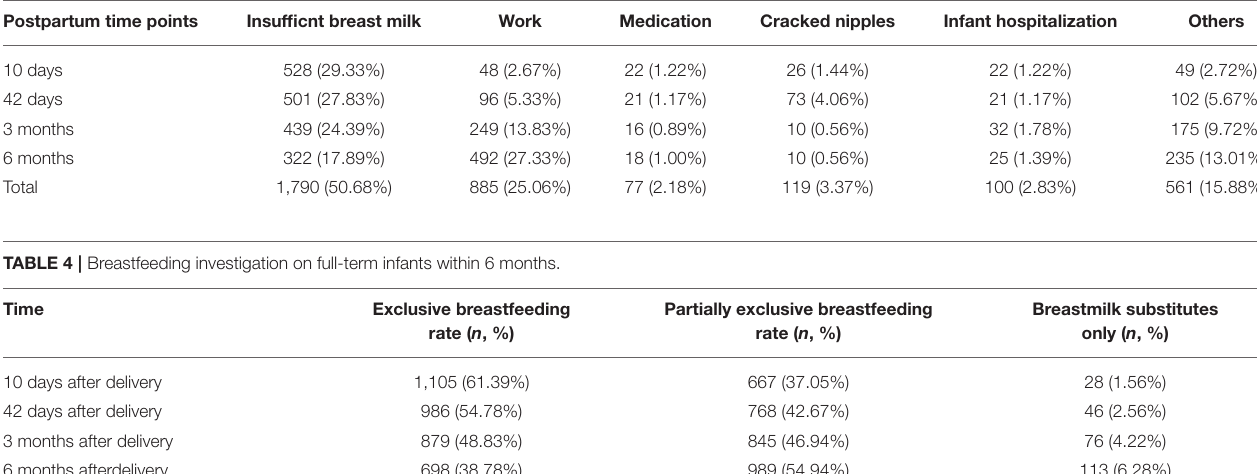
TABLE 3 | The reasons of formula powder feeding during follow-up [ n (%)].